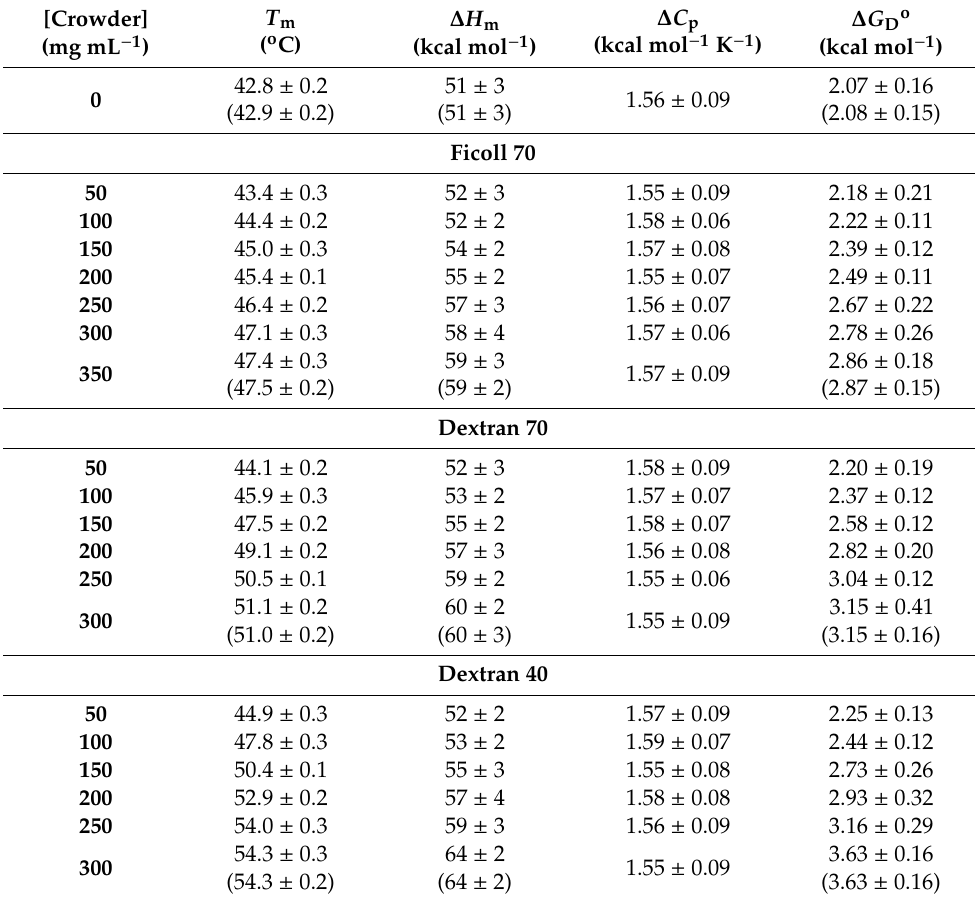
Table 1. Thermodynamic parameters associated with the thermal denaturation of α -LA in the absence and presence of varying concentrations of ficoll 70, dextran 70, and dextran 40 at pH 7.0 a,b